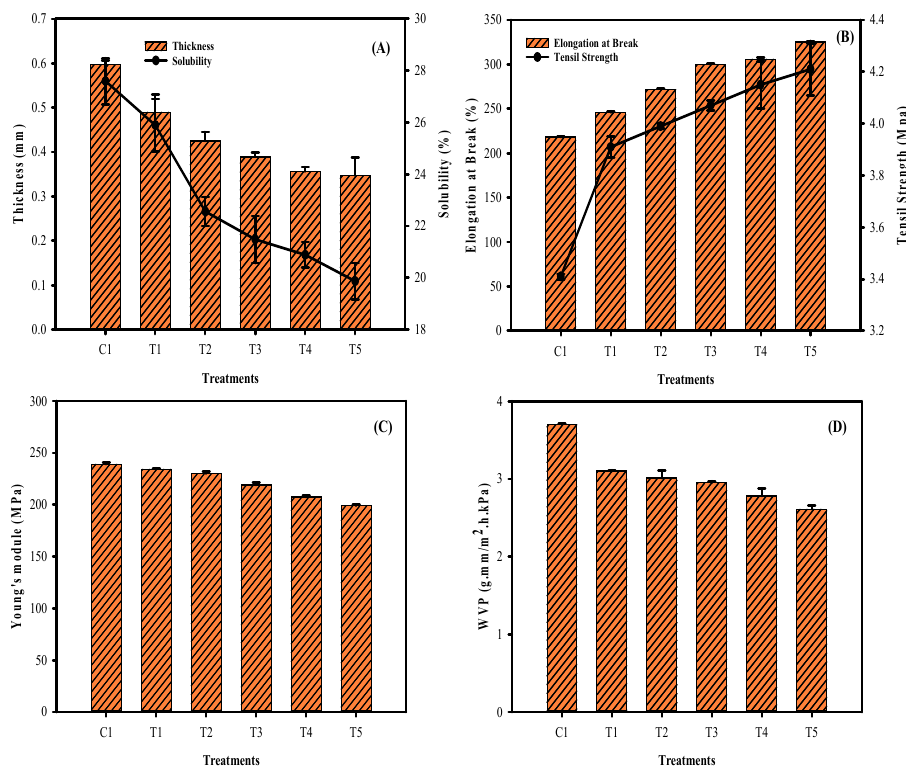
Figure 2. Thickness ( A ), solubility ( A ), elongation at break ( B ), tensile strength ( B ), Young’s modulus ( C ), and water vapor pressure ( D ) of the mung bean phyto-film that incorporated LPE and was processed under sonication.